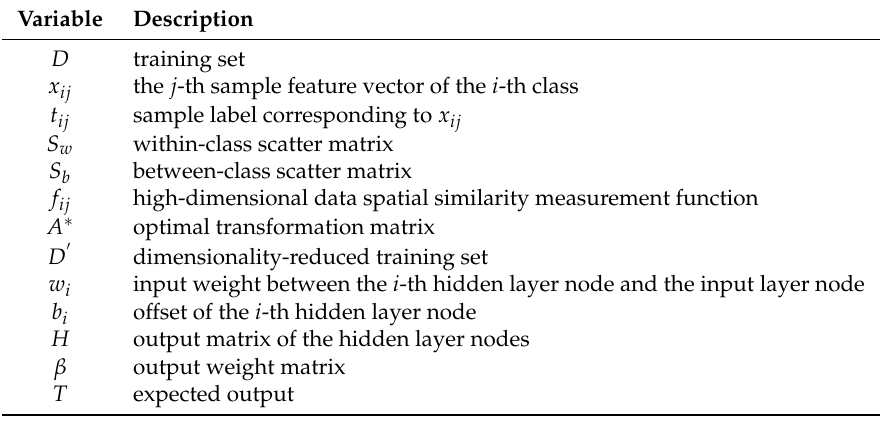
Table 1. The correlated variables of the intrusion detection algorithm